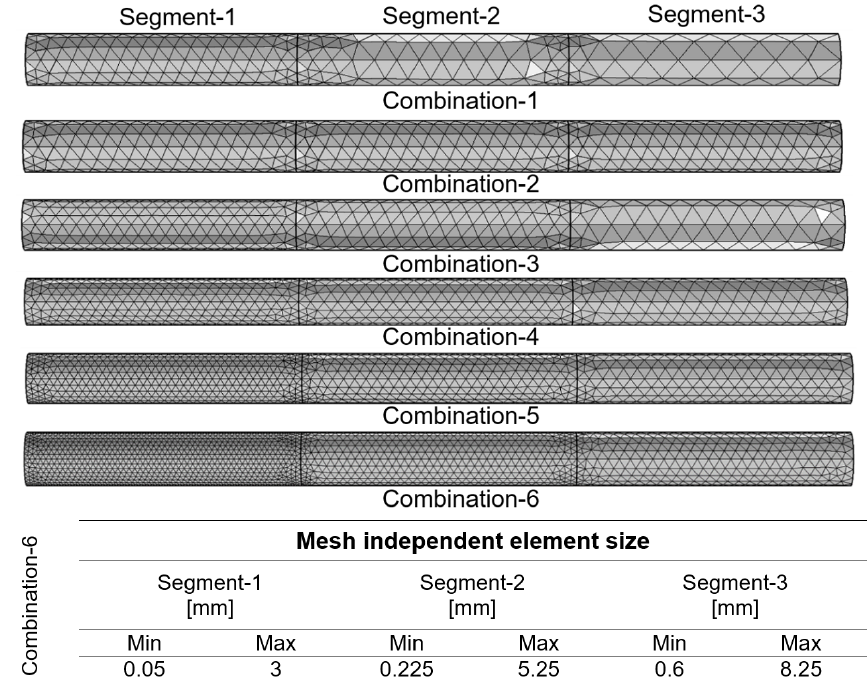
Figure 6. Mesh refinement study using COMSOL Multiphysics ® and mesh element sizes used for